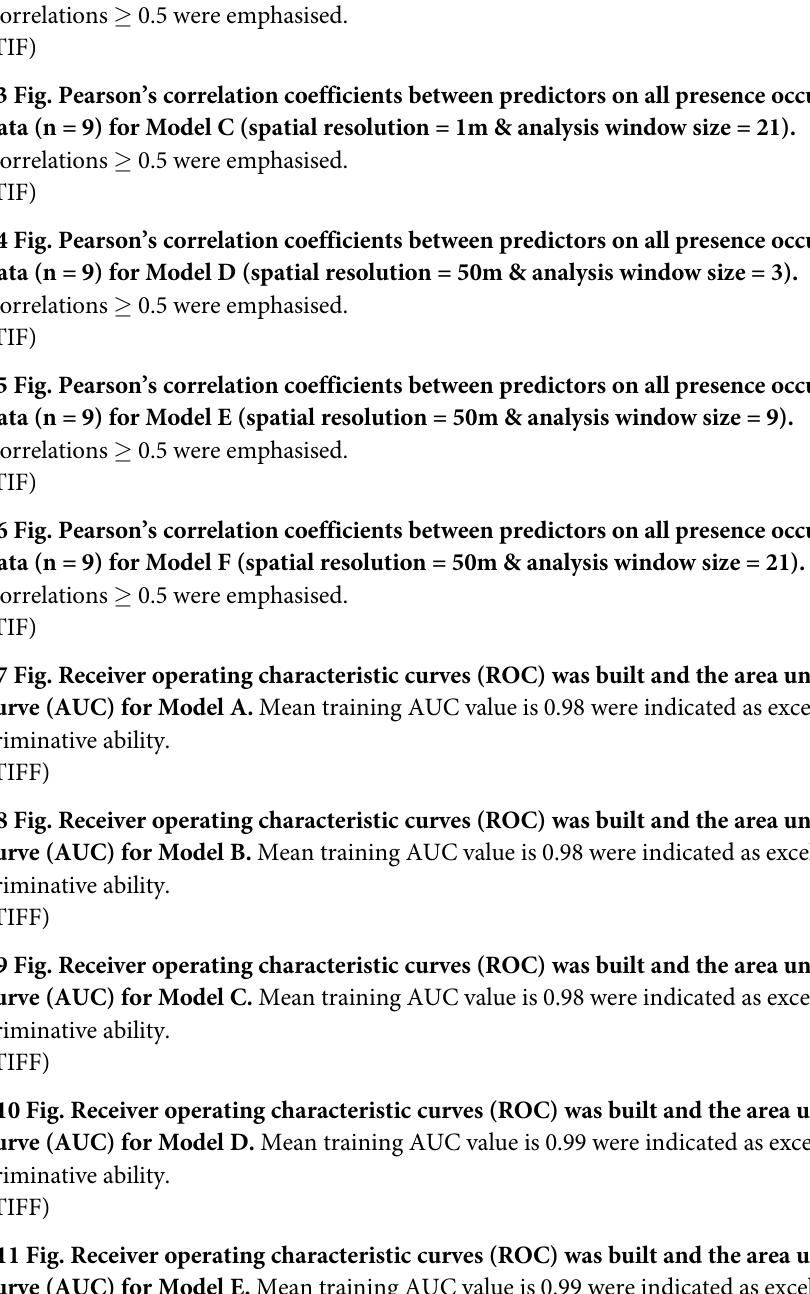
S1 Fig. Pearson’s correlation coefficients between predictors on all presence occurrence data (n = 9) for Model A (spatial resolution = 1m & analysis window size = 3). Correlations � 0.5 were emphasised. (TIF) S2 Fig. Pearson’s correlation coefficients between predictors on all presence occurrence data (n = 9) for Model B (spatial resolution = 1m & analysis window size = 9). Correlations � 0.5 were emphasised. (TIF) S3 Fig. Pearson’s correlation coefficients between predictors on all presence occurrence data (n = 9) for Model C (spatial resolution = 1m & analysis window size = 21). Correlations � 0.5 were emphasised. (TIF) S4 Fig. Pearson’s correlation coefficients between predictors on all presence occurrence data (n = 9) for Model D (spatial resolution = 50m & analysis window size = 3). Correlations � 0.5 were emphasised. (TIF) S5 Fig. Pearson’s correlation coefficients between predictors on all presence occurrence data (n = 9) for Model E (spatial resolution = 50m & analysis window size = 9). Correlations � 0.5 were emphasised. (TIF) S6 Fig. Pearson’s correlation coefficients between predictors on all presence occurrence data (n = 9) for Model F (spatial resolution = 50m & analysis window size = 21). Correlations � 0.5 were emphasised. (TIF) S7 Fig. Receiver operating characteristic curves (ROC) was built and the area under the curve (AUC) for Model A. Mean training AUC value is 0.98 were indicated as excellent dis- criminative ability. (TIFF) S8 Fig. Receiver operating characteristic curves (ROC) was built and the area under the curve (AUC) for Model B. Mean training AUC value is 0.98 were indicated as excellent dis- criminative ability. (TIFF) S9 Fig. Receiver operating characteristic curves (ROC) was built and the area under the curve (AUC) for Model C. Mean training AUC value is 0.98 were indicated as excellent dis- criminative ability. (TIFF) S10 Fig. Receiver operating characteristic curves (ROC) was built and the area under the curve (AUC) for Model D. Mean training AUC value is 0.99 were indicated as excellent dis- criminative ability. (TIFF) S11 Fig. Receiver operating characteristic curves (ROC) was built and the area under the curve (AUC) for Model E. Mean training AUC value is 0.99 were indicated as